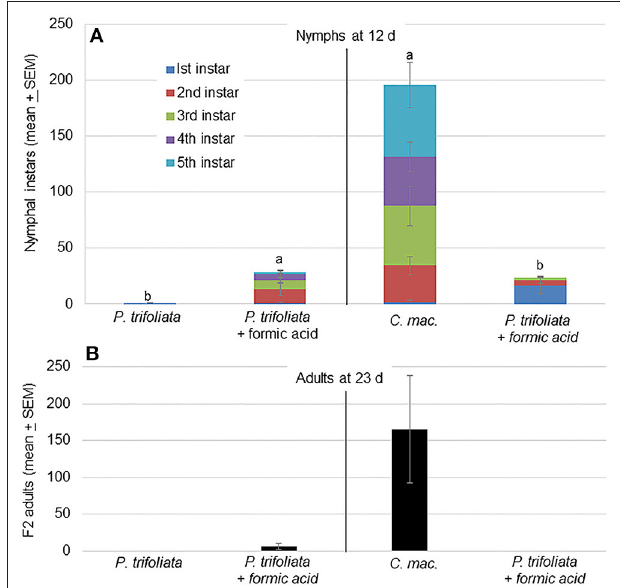
FIGURE 3 | (A) Mean ( ± SEM, n = 4) number of D. citri nymphal instars on individual plants in two treatment cages 12 d after introduction of psyllids. Significantly more nymphs were located on P. trifoliata exposed to vapor phase formic acid compared with the number on untreated (control) plants [ F (1,5) = 11.9; P = 0.01]. In a separate test, more nymphs were observed on untreated C. macrophylla plants compared with the number on P. trifoliata plants exposed to formic acid [ F (1,5) = 10.8; P = 0.03]. Treatments followed by the same letters are not significantly different by Tukey’s HSD ( α = 0.05) following a significant ANOVA. (B) Number of F2 adults present on plants 23 d after start of the